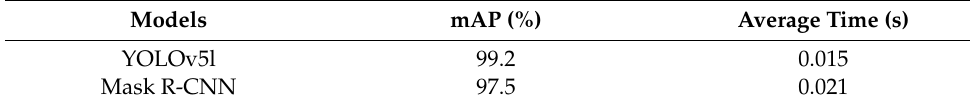
Table 2. Comparison models of YOLOv5l and Mask